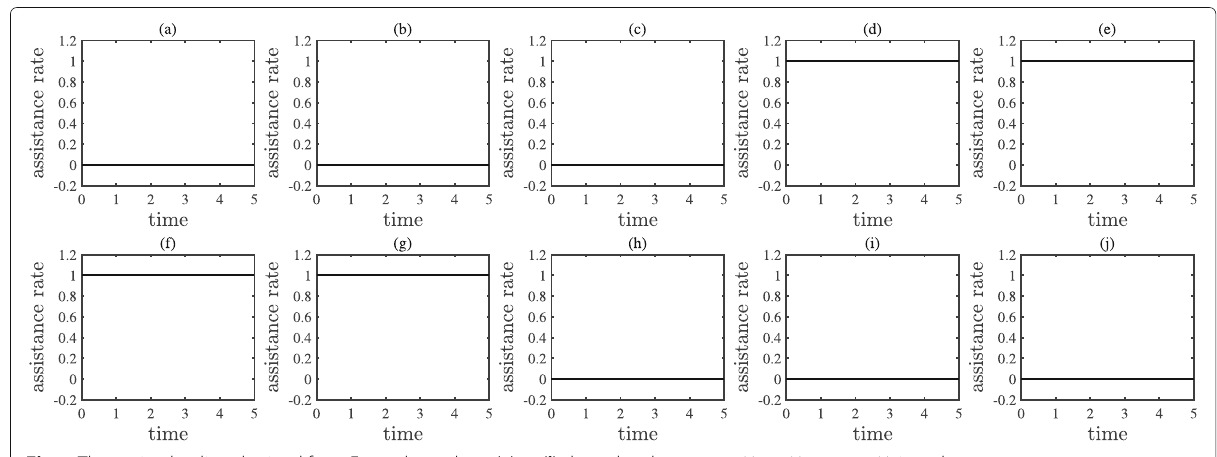
Fig. 5 The optimal policy obtained from Example 1, where ( a ) to ( j ) show the elements u 1 ( t ) , u 2 ( t ) , ... , u 10 ( t ) in order